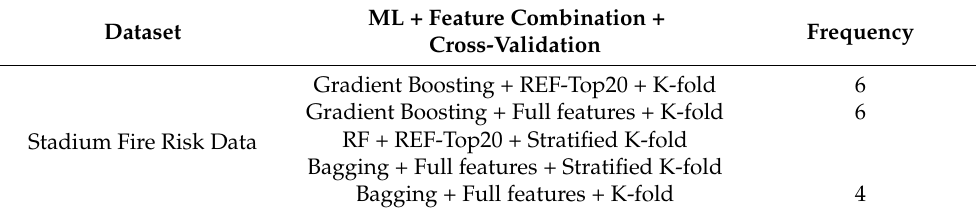
Table 9. The top three models appearing in the top five in all performance evaluation metrics.